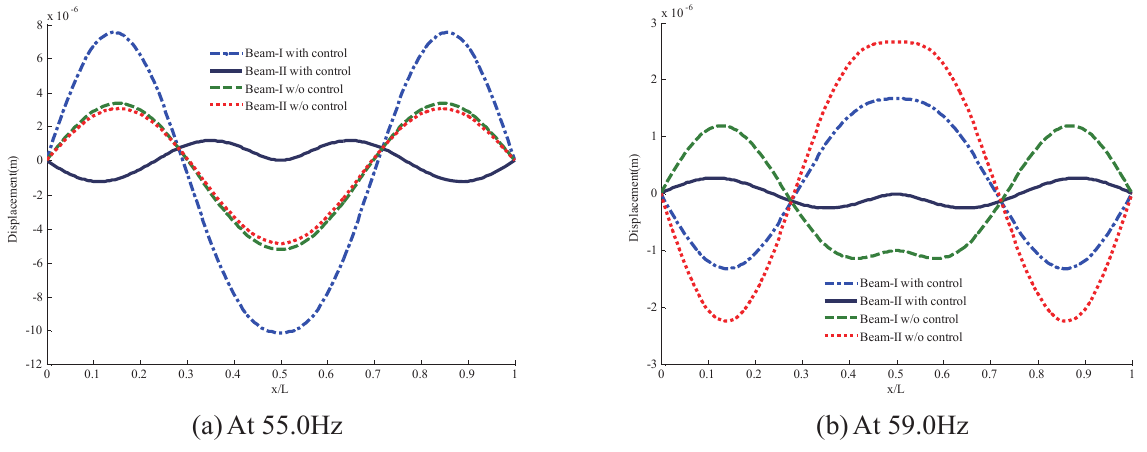
Fig. 9. Displacements of the coupled beams.